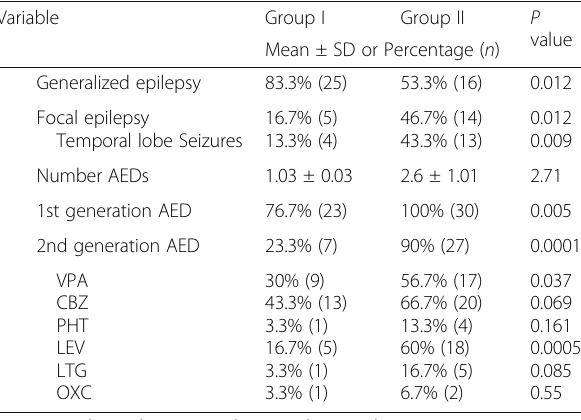
Table 6 Comparison between both groups regarding epilepsy related clinical data